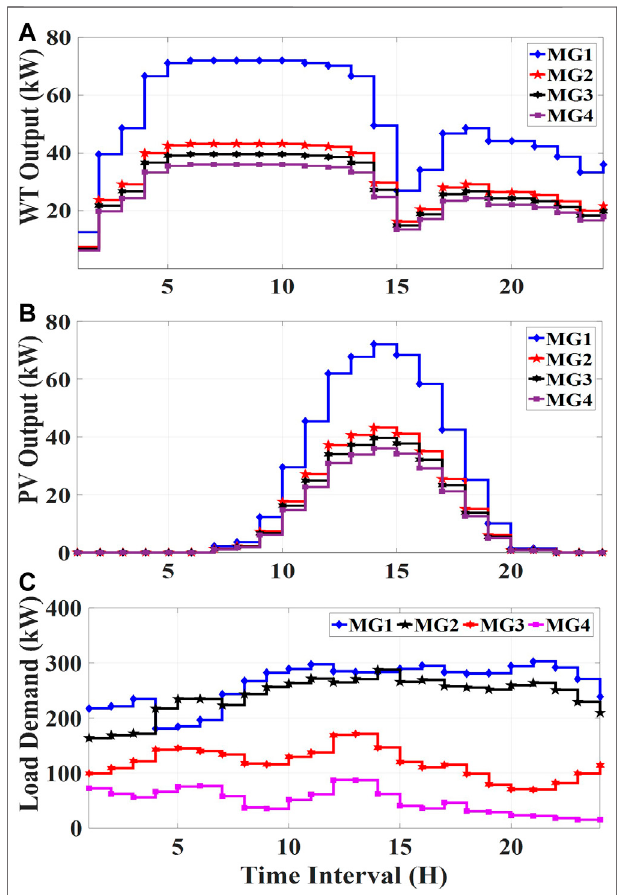
FIGURE 4 | Forecast values of the power outputs of the (A) WT, (B) PV, and (C) load.